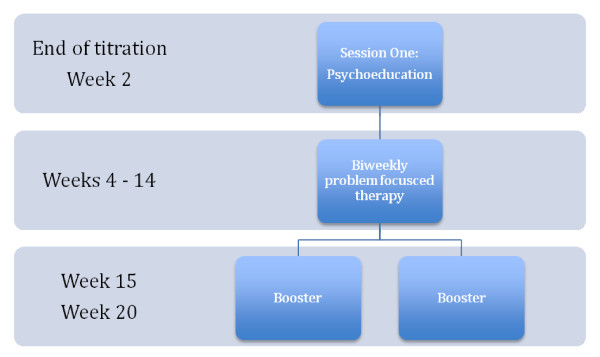
Treatment Schedule.